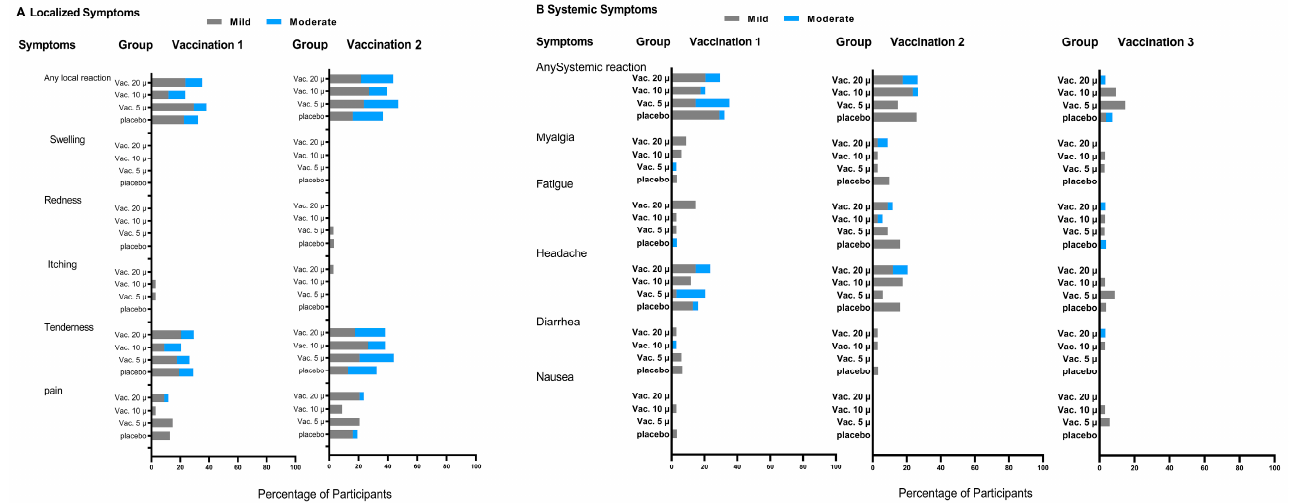
Figure 2. Solicited local and systemic adverse reactions. The percentage of the participants with adverse reactions in each intervention group according to the FDA toxicity grades (mild, moderate, severe, and life-threatening) during the seven-day period after each dose. There were no grade 3 (severe) or grade 4 (life-threatening) events.